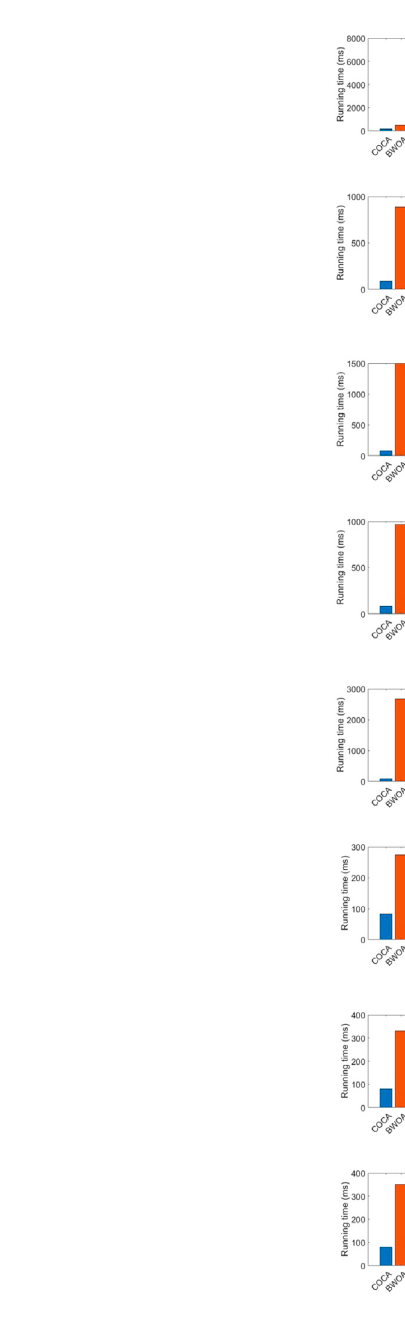
FIGURE 3 CPU running time consumed by the various algorithms entered into